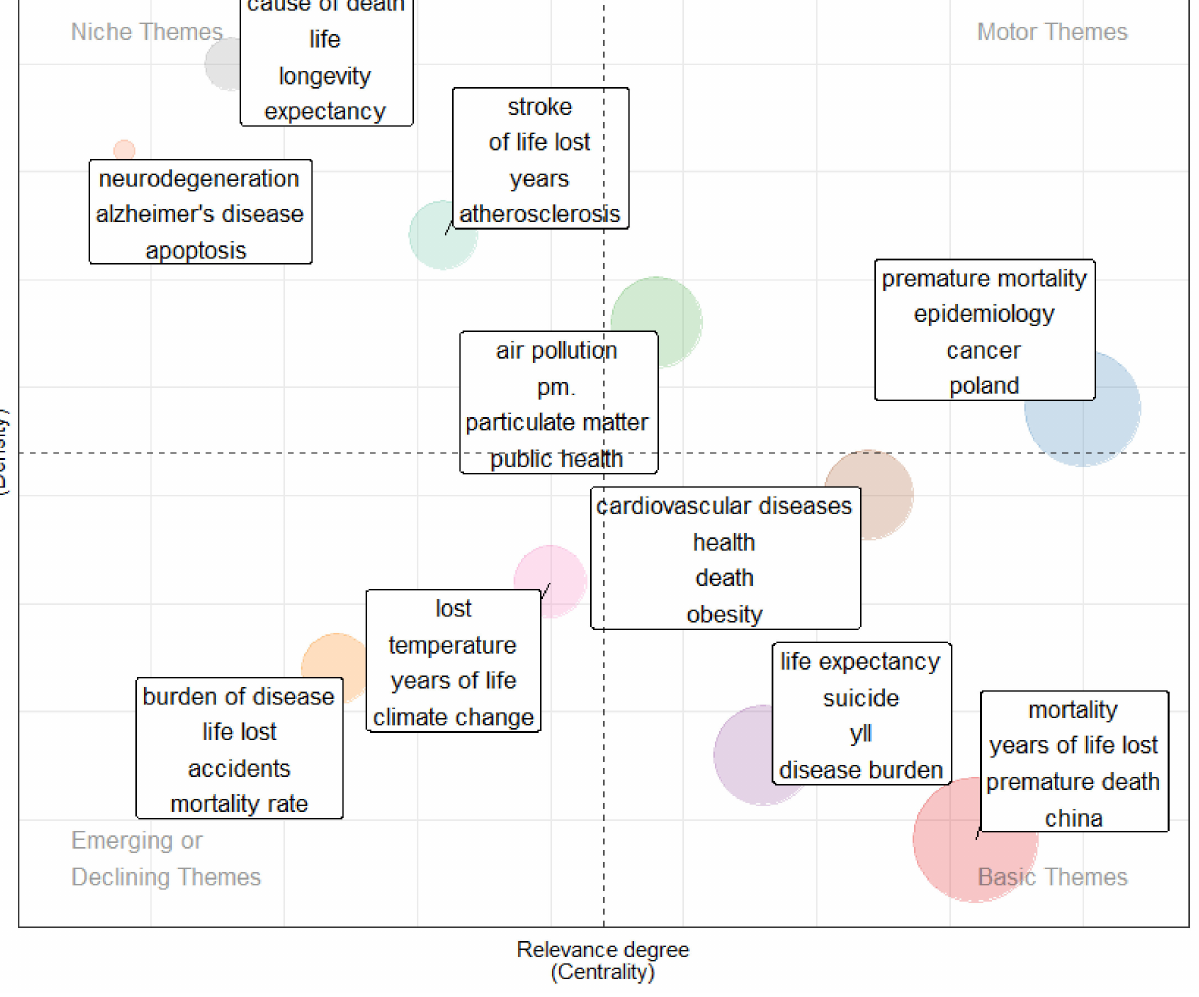
Figure 6. Thematic map of publications related to premature